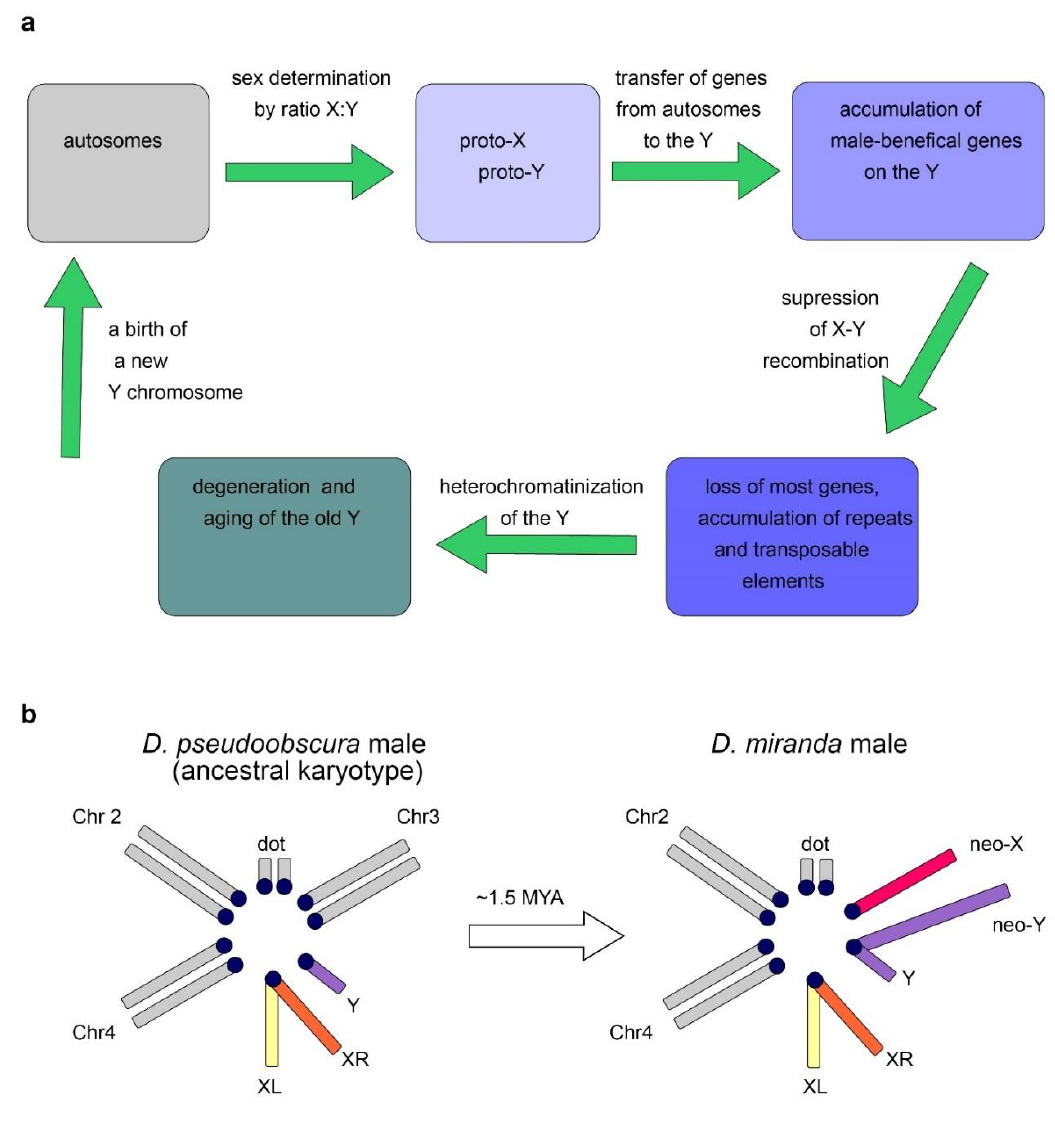
Figure 2. ( a ) Putative Y chromosome life cycle in genus Drosophila . It starts with the origin of proto-Y from the autosome, then goes throughout accumulation of genes necessary for spermatogenesis and male fitness, cessation of the X-Y recombination, degeneration of the bulk of acquired genes, heterochromatinization, aging, and arising from autosomes repeatedly. ( b ) The scheme of the karyotype of D. miranda males and its close relative species D. pseudoobscura , from which D. miranda diverged about 2 MYA. In D. miranda , the fusion of chromosome 3 with the ancestral Y chromosome created the neo-Y chromosome about 1.5 MYA. XL and XR indicate the left and right arm of the ancestral X chromosome. The scheme is modified from